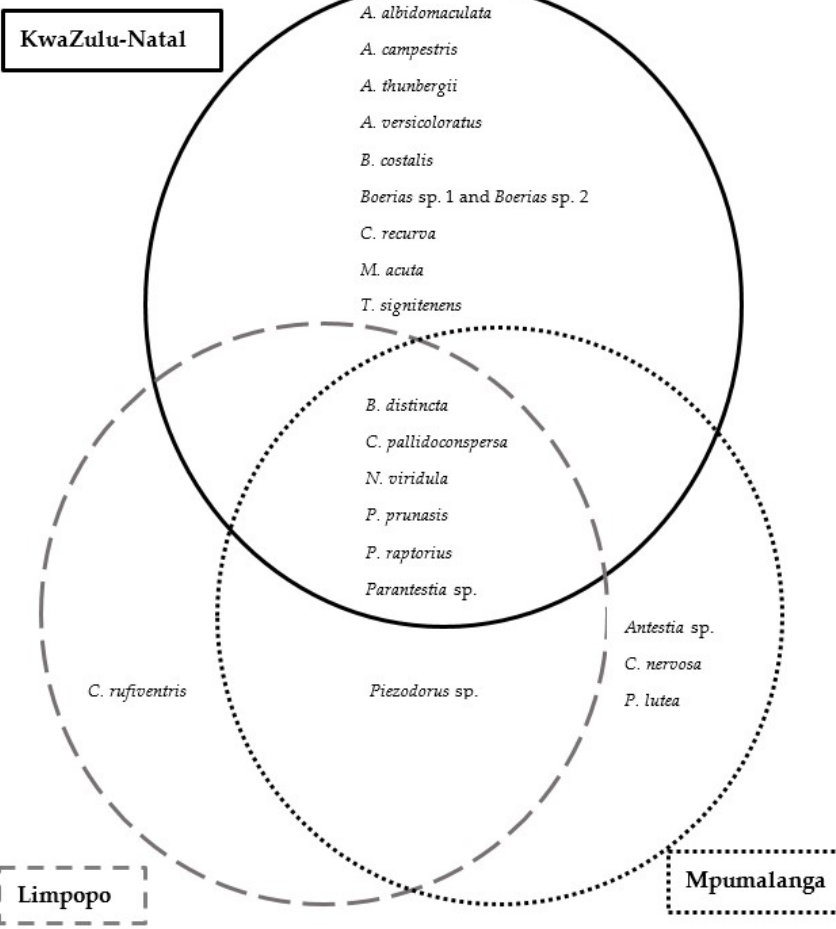
Figure 4. Stink bug species presence in KwaZulu-Natal, Limpopo and Mpumalanga for the 2019–2020 growing season.